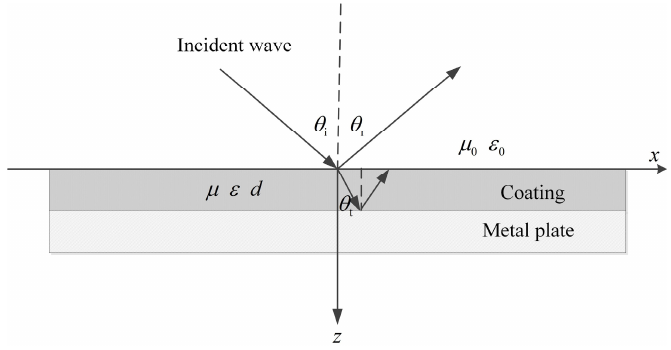
Figure 1. Propagation of vertically polarized wave in the absorbing ‐ material coating.